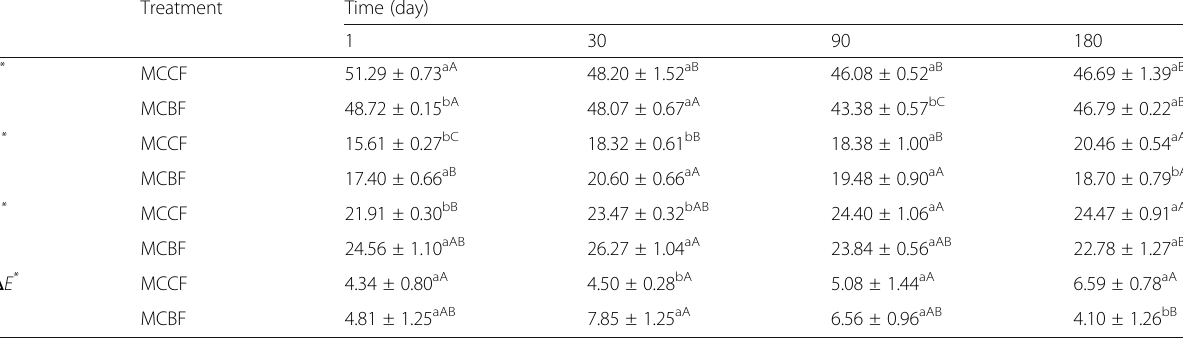
Table 4 Color of crawfish minced meat during frozen